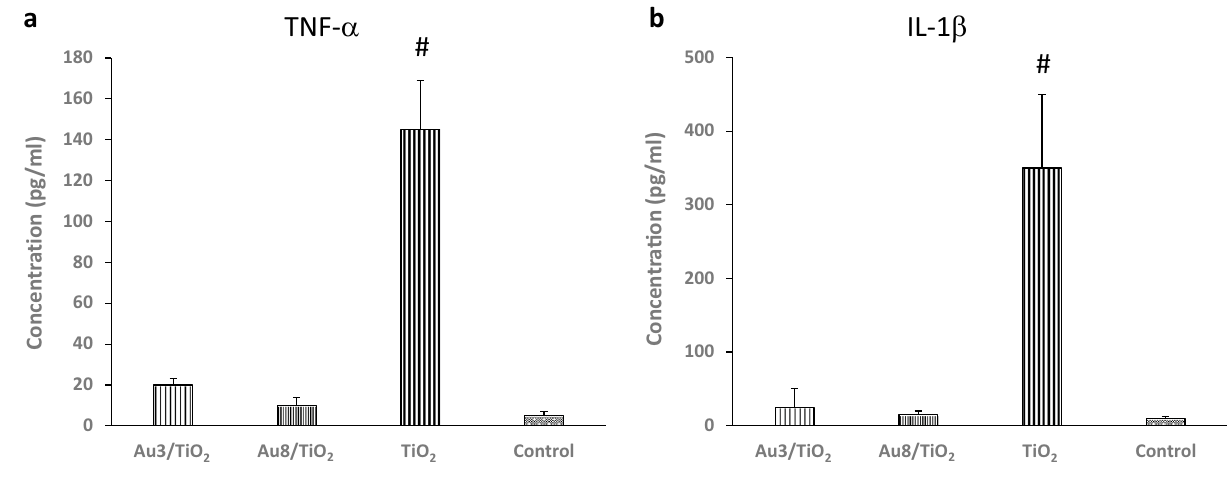
Figure 4. Effect of Au3/TiO 2 , Au8/TiO 2 and TiO 2 NPs (50 µg ml −1 , 6 h incubation) on TNF-α and IL-1β secretion by mouse peritoneal macrophages ( a , b ). Data are expressed as picograms/ml in cell culture medium and are represented as mean ± SEM of 6 independent experiments. # Significantly different from control ( p < 0.01).